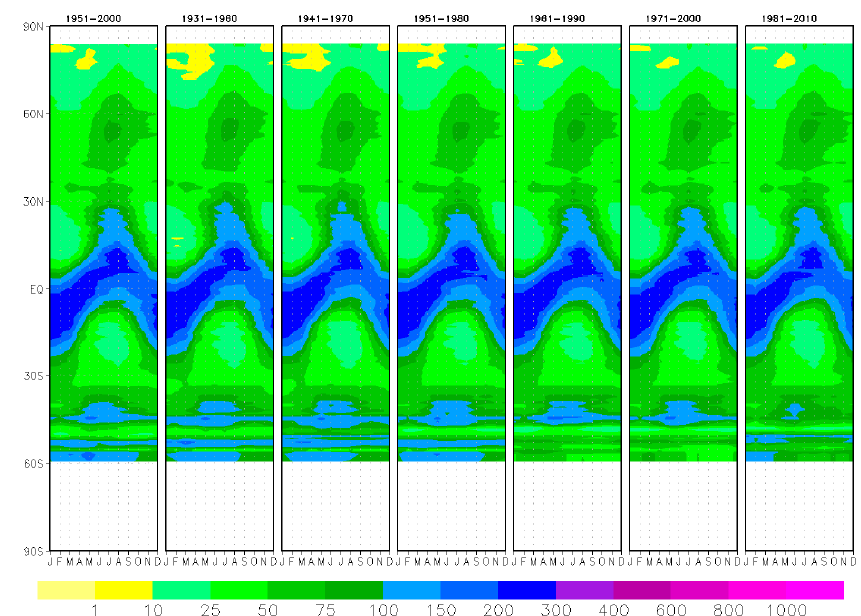
Figure 6. Hovmoeller diagram of zonal mean precipitation (mm/month) over the year for (left) GPCC’s precipitation climatology 1951–2000, and the different 30-year reference periods (second-left to